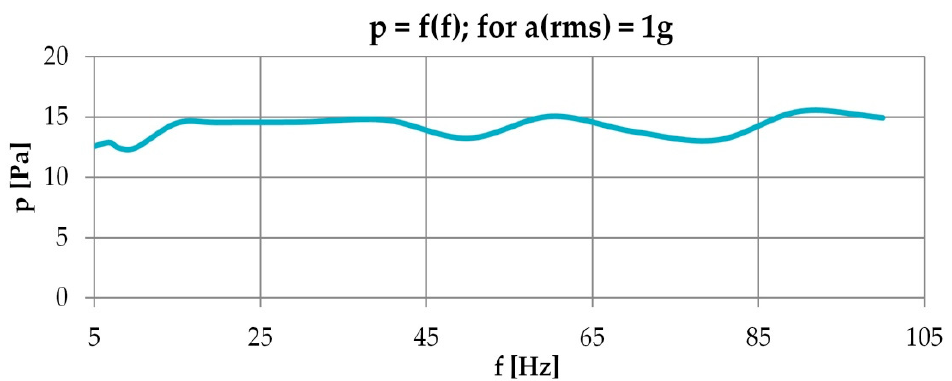
Figure 6. Dependency chart of the output signal (RMS) in Pascals for harmonic signal up to 100 Hz, for the MPX2010D sensor [25,26].